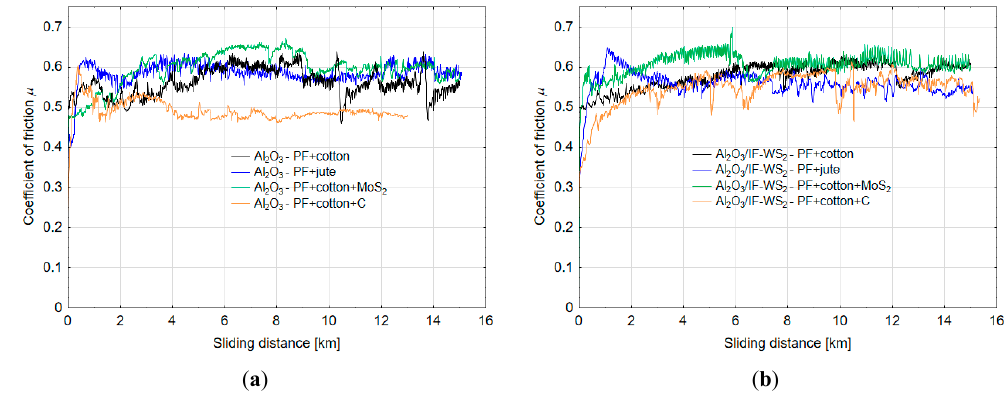
Figure 17. Coefficient of friction vs. sliding distance for tribological pairs of: ( a ) Al 2 O 3 –PF composites and ( b ) Al 2 O 3 / IF-WS 2 -PF composites.